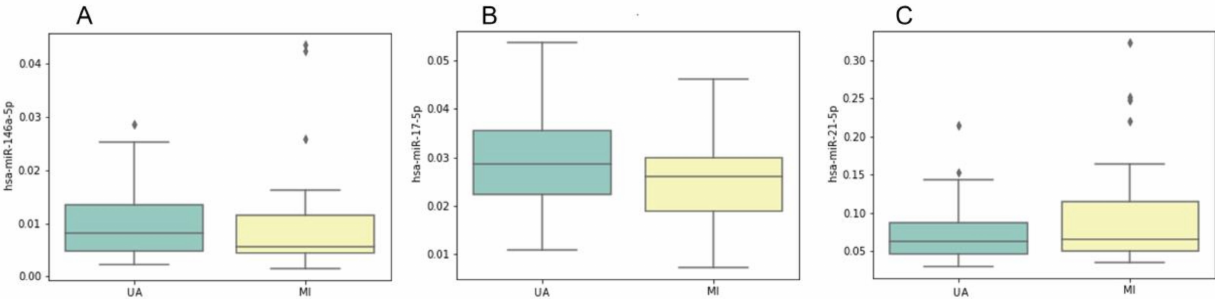
Figure 4. Relative miRNA plasma levels in the study sample groups within the ACS group (n = 50) for miR-146a-5p ( A ), miR-17-5p ( B ) and miR-21-5p ( C ). UA, 26 patients with unstable angina; MI, 24 patients with myocardial infarction (STEMI + NSTEMI). On the y -axis, relative miRNA plasma levels (normalized to miR-16-5p) are shown. The boxplots represent median and interquartile ranges (IQRs) in the box, minimum and maximum values in the “whiskers”, and outliers in the